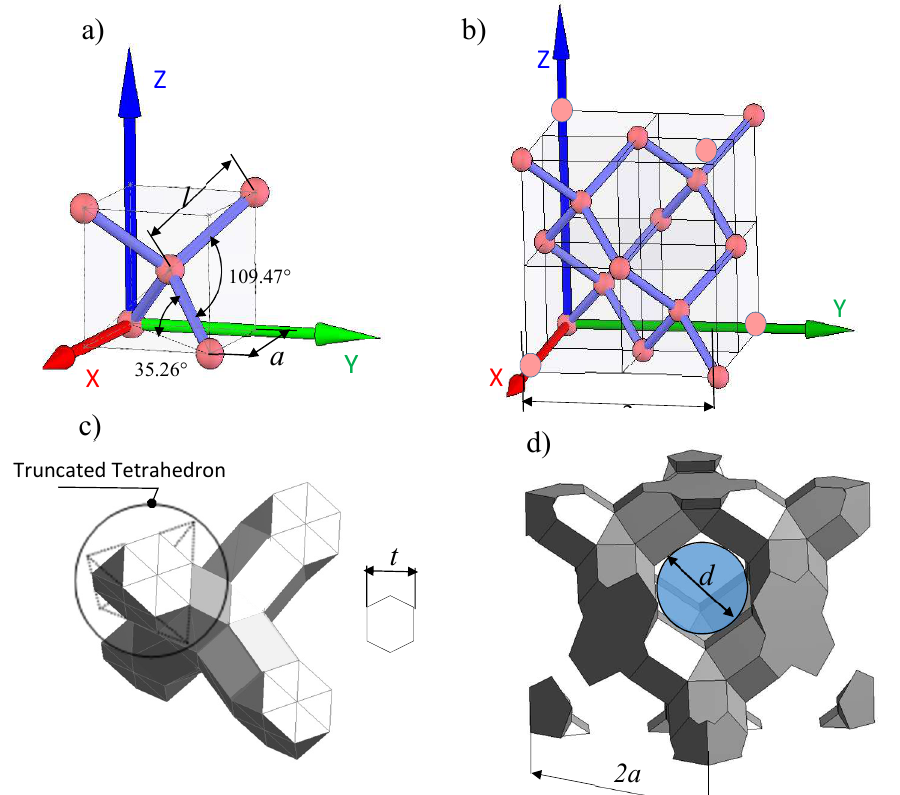
Figure 2. Diamond cell adopted for the lattice structure: ( a ) cross-shaped substructure made of nodes and struts; ( b ) periodic cubic unit cell; ( c ) modeled cross-shaped unit cell; ( d ) modeled periodic cubic unit cell.